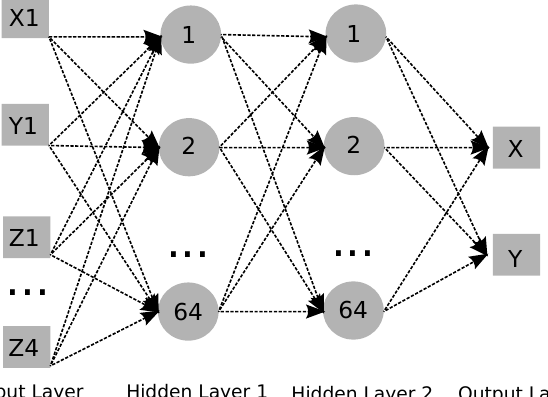
Figure 19. Neural network